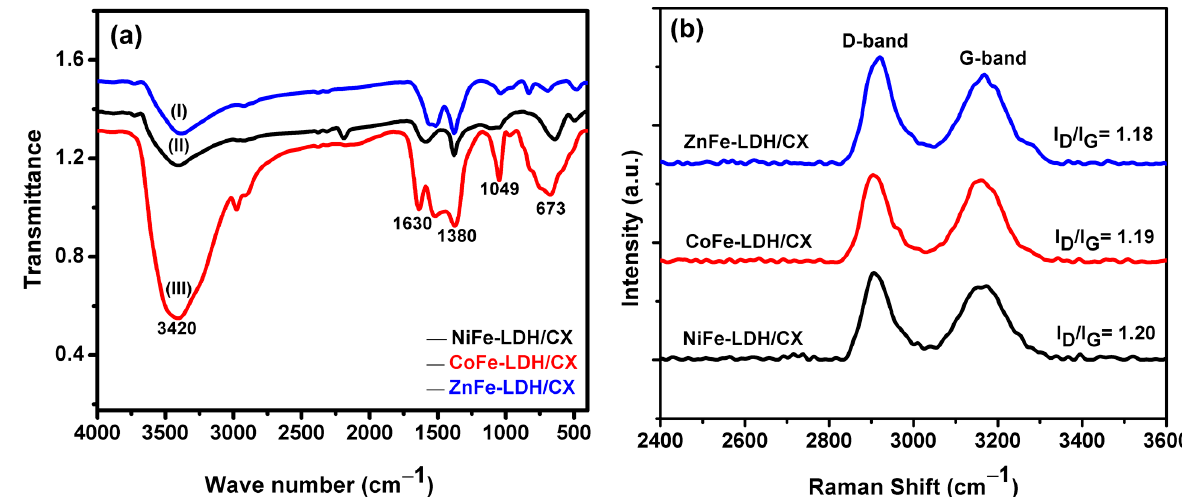
Figure 4. ( a ) FTIR spectra of hybrid (I) ZnFe-LDH/CX, (II) NiFe-LDH/CX, and (III) CoFe-LDH/CX, and ( b ) FT-Raman.